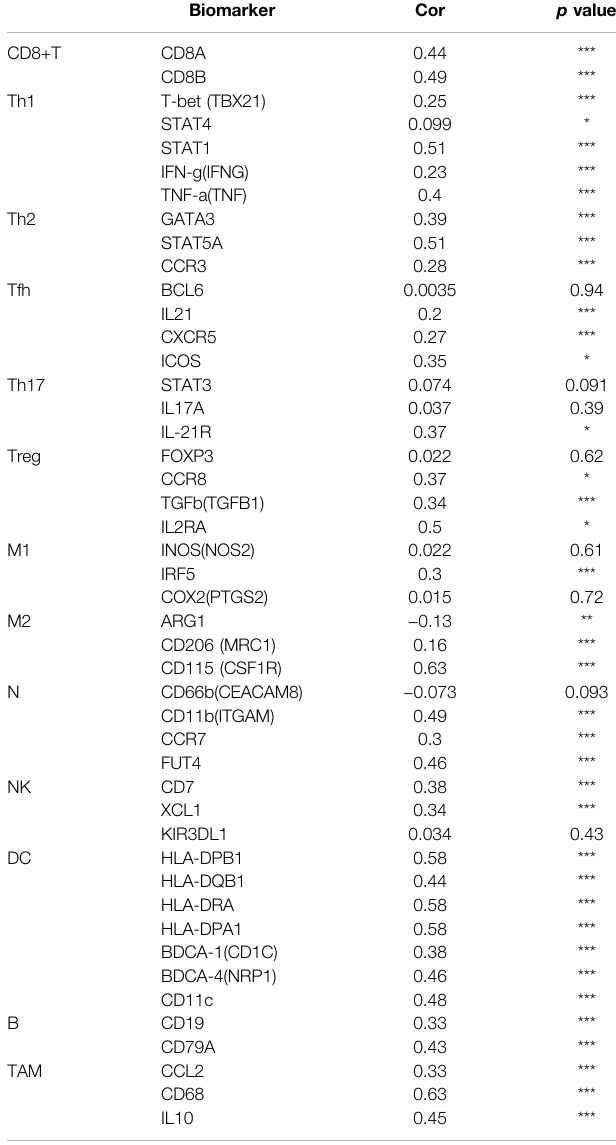
TABLE 4 | Correlation analysis between RAB42 expression and immune cell markers in HCC. Biomarker Cor